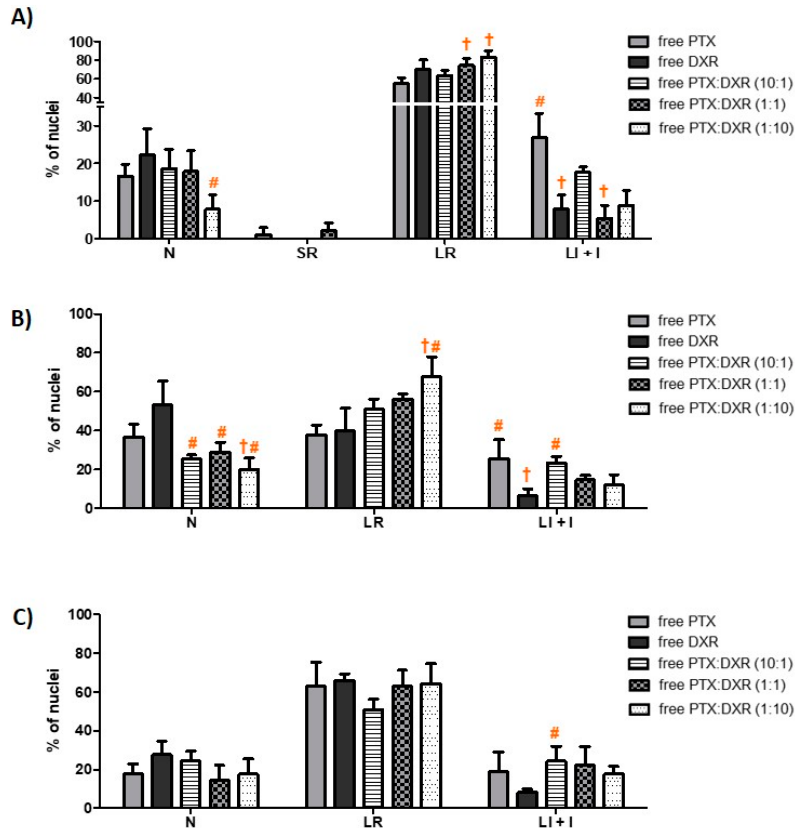
Figure 2. Nuclear morphometric distribution of MDA-MB-231 ( A ), MCF-7 ( B ) and SKBR-3 ( C ) cell line nuclei exposed to 70 nM of different treatments for 48 h. Data shown represent the mean ± SD of three independent experiments. † = di ff ers statistically from the PTX treatment; # = di ff ers statistically from the DXR treatment. Data for MDA-MB-231 and MCF-7 cell lines were transformed as y = square root(value) and for SKBR-3 cell line as y = log(value) prior to perform ANOVA ( P < 0.05). Ratio in parenthesis refers to PTX:DXR molar ratio. Abbreviations: DXR, doxorubicin; PTX, paclitaxel; LI + I, large irregular plus irregular; LR, large regular; N, normal; SR, small regular.